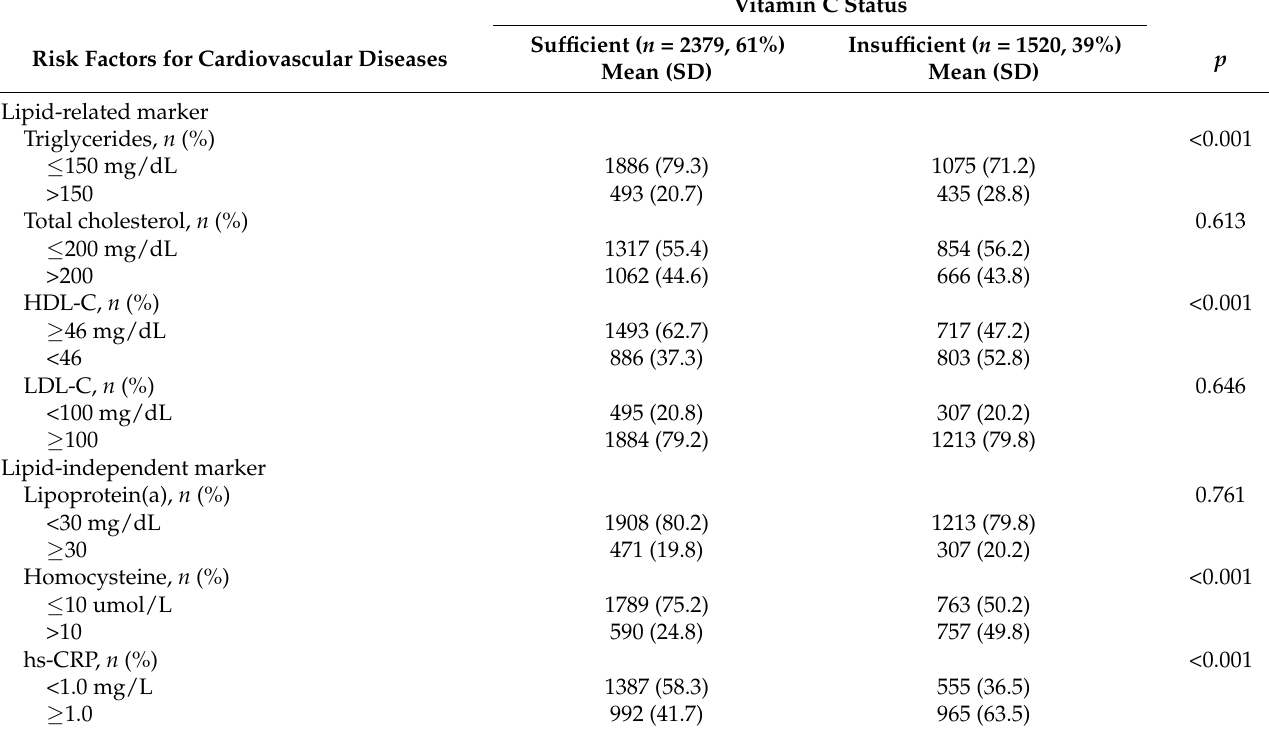
Table 4. Lipid-related and lipid-independent risk factors for cardiovascular diseases in subjects with sufficient and insufficient vitamin